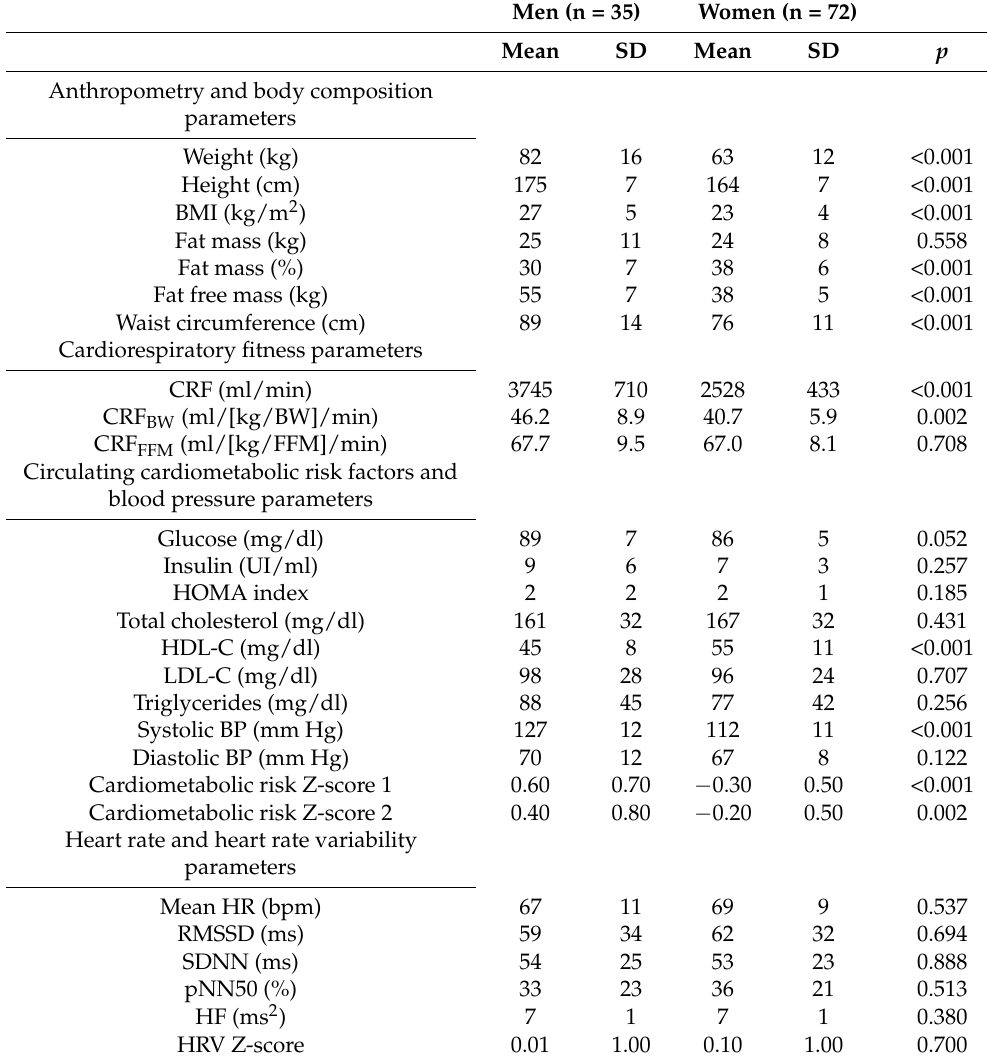
Table 1. Participants’ descriptive